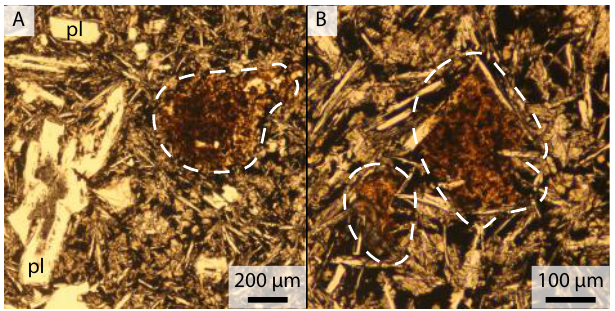
Figure 8: Plane polarized light images show entrained tephra incorporated as a coherent and well-integrated mass into the groundmass of lava sample TNG-33.